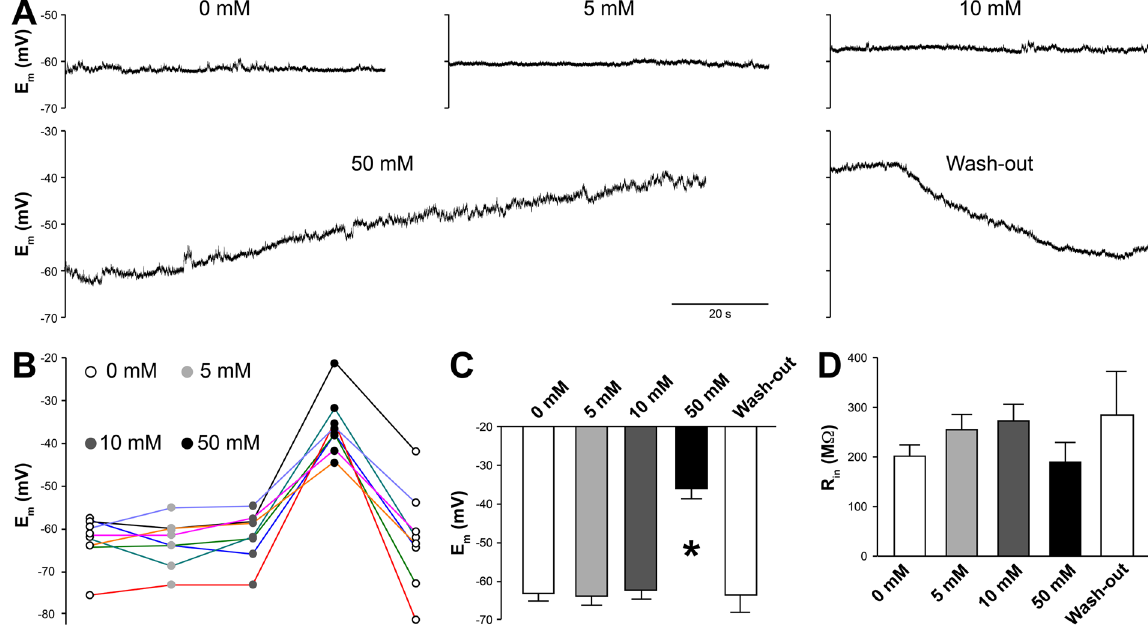
Figure 1. Effects of ammonium chloride (NH 4 Cl) on passive membrane properties. ( A ) Sample traces of resting membrane potential